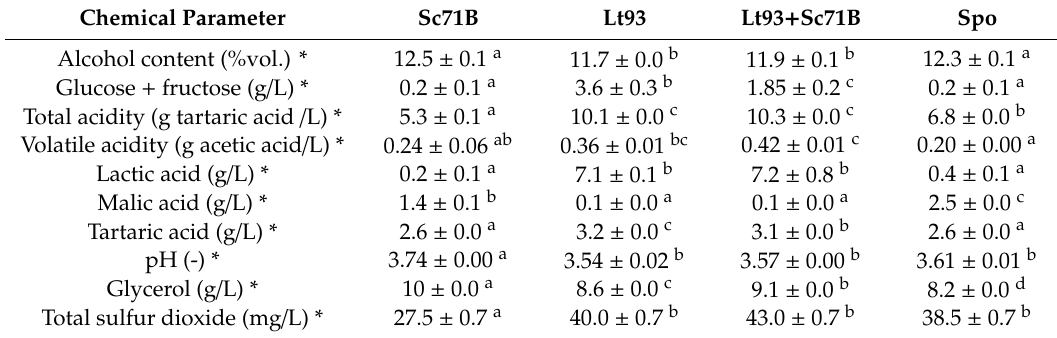
Table 4. Characteristics of Menc í a wines elaborated with S. cerevisiae Sc71B, L. thermotolerans Lt93, sequential fermentation of both strains and by spontaneous fermentation (Spo).